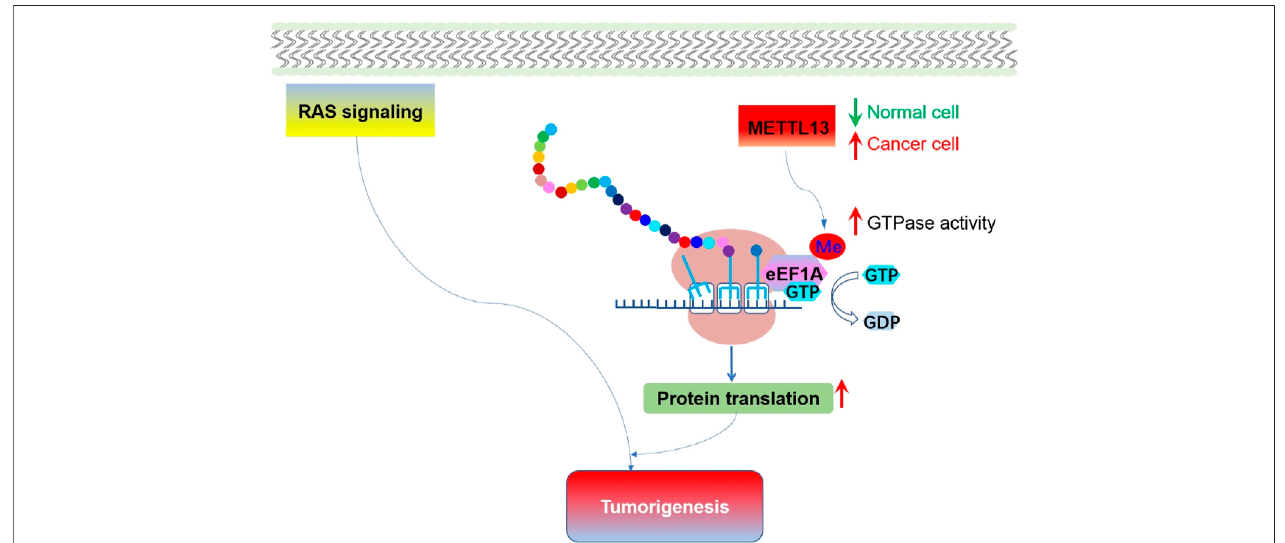
FIGURE 7 | Methylation of eEF1A and the role of eEF1AK55me2 mediated translational control in tumorigenesis. Expression of METTL13 and eEF1AK55me2 are upregulated in cancer, and negatively correlate with the survival of pancreatic and lung cancer patient. Increased METTL13 and eEF1AK55me2 promotes Ras-driven tumorigenesis in vivo .